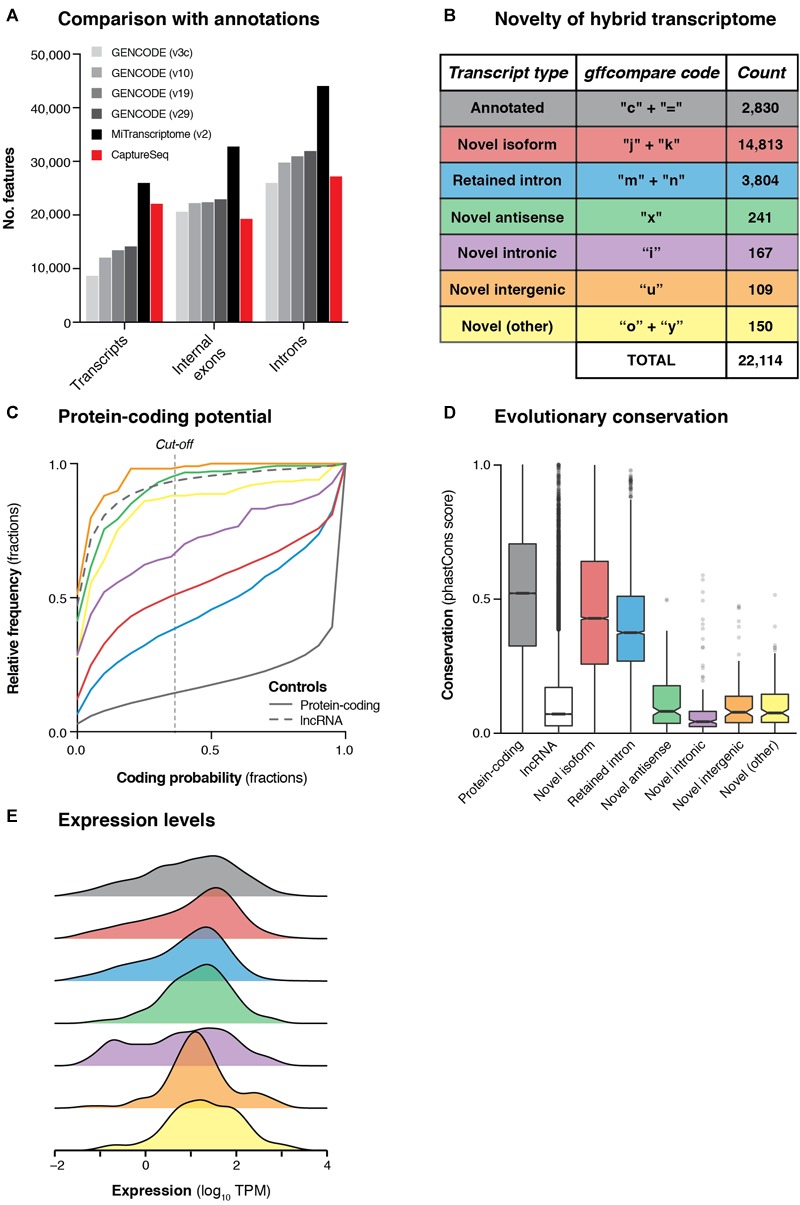
Transcriptional landscape of haplotype blocks associated with neuropsychiatric functions. (A) Bar charts show the number of transcripts, introns and internal exons contained in our filtered hybrid transcriptome (red) compared to existing annotations (four versions of GENCODE and MiTranscriptome v2). Only multi-exonic transcripts that overlap with targeted haplotype blocks are considered in this analysis. (B) Table shows the classification of transcripts in our hybrid transcriptome in relation to the latest GENCODE annotation (v29). (C) Cumulative frequency histograms show the coding potential of our transcripts, as assessed by CPAT. Colors refer to the categories defined in part (B). Vertical dotted line indicates the commonly used cut-off for human transcripts (0.364). GENCODE (v29) annotated lncRNAs (gray dotted line) and protein-coding genes (gray solid line) are also plotted for reference. (D) Box plots show the distribution of phastCons scores (Siepel et al., 2005) (vertebrate 100-way alignment) of our transcripts, colored by type. Box edges indicate lower and upper quartiles, center lines indicate median, notches indicate the 95% confidence interval around the median. (E) Density plots show the mean expression (log10 TPM) of transcripts across all four samples, as measured by Illumina short-read sequencing.